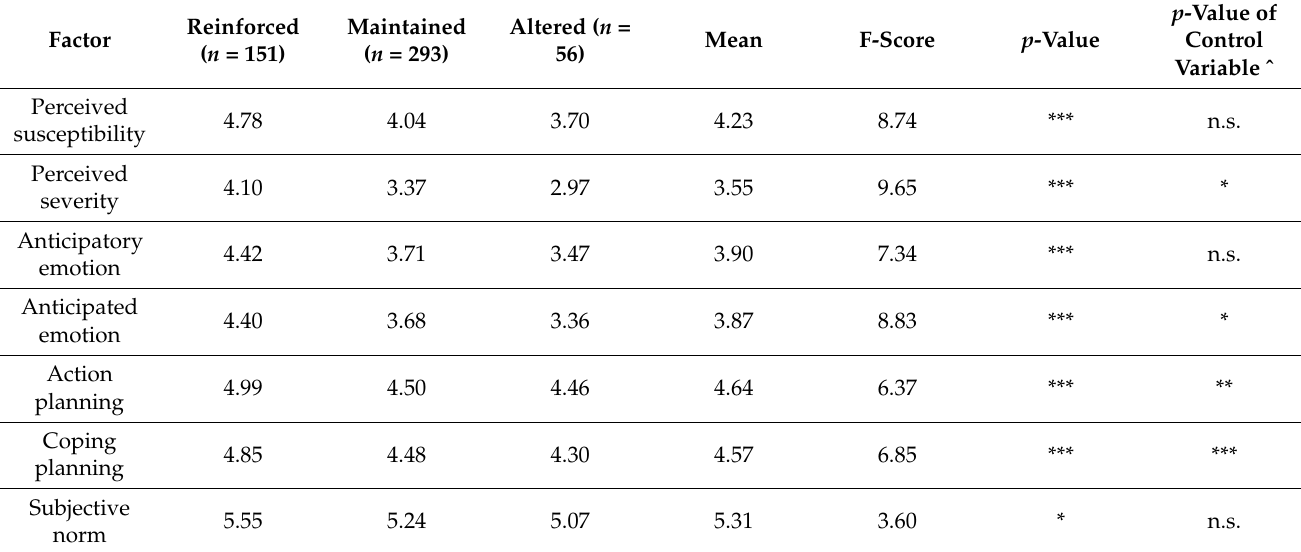
Table 5. ANCOVA test results (altered, maintained and reinforced